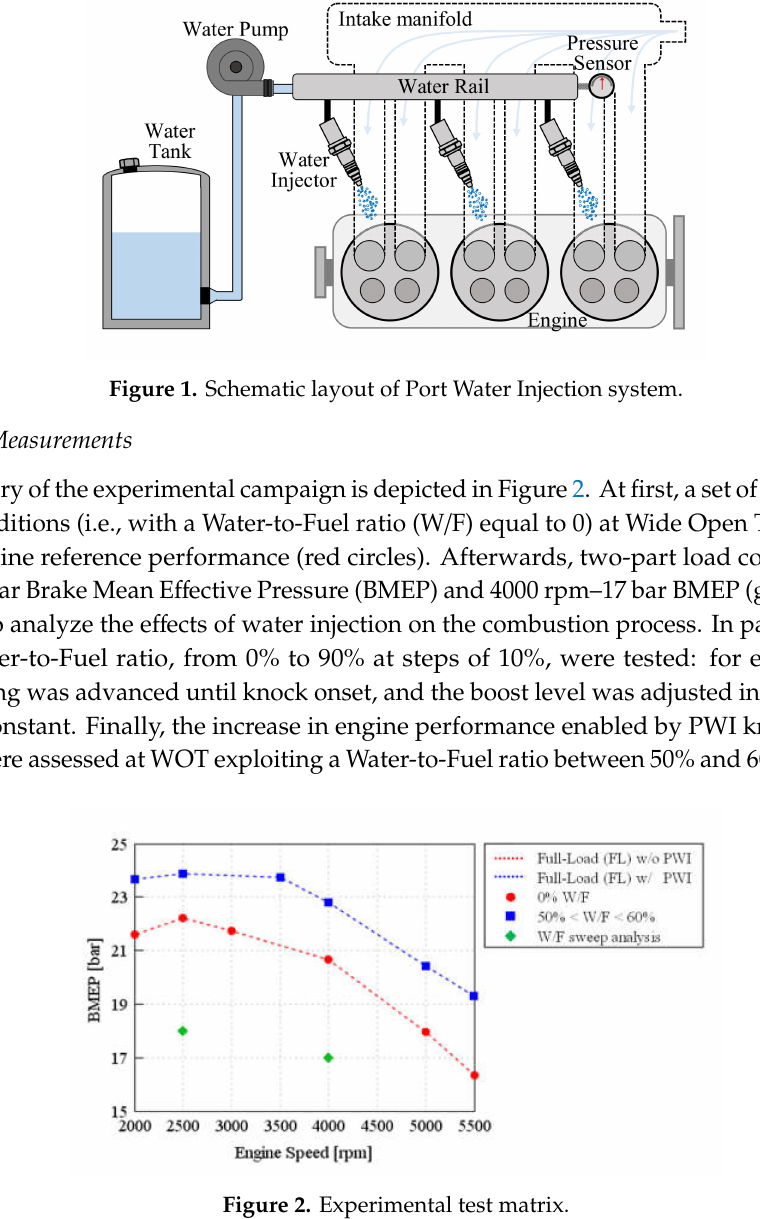
Figure 2. Experimental test